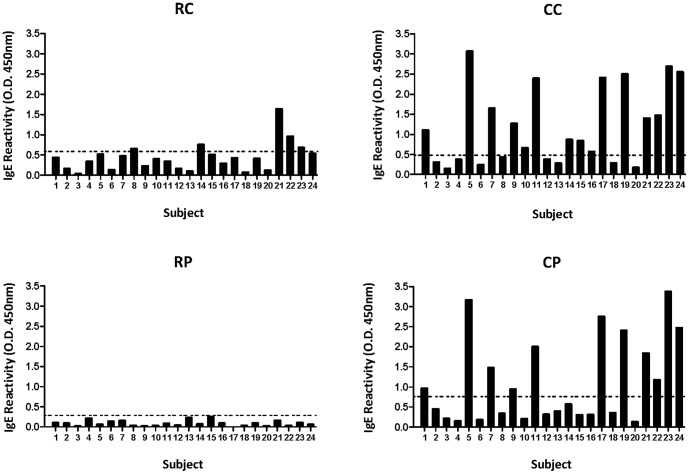
ELISA for serum IgE reactivity to shellfish extracts.ELISA for serum IgE reactivity to raw blue swimmer crab (RC), cooked blue swimmer crab (CC), raw black tiger prawn (RP) and cooked black tiger prawn (CP) for 24 shellfish-allergic subjects. The cut-off of two standard deviations above mean reactivity of 7 non-atopic subjects to each of the extracts is indicated by the dotted line (0.56 for RC, 0.49 for CC, 0.29 for RP and 0.75 for CP).